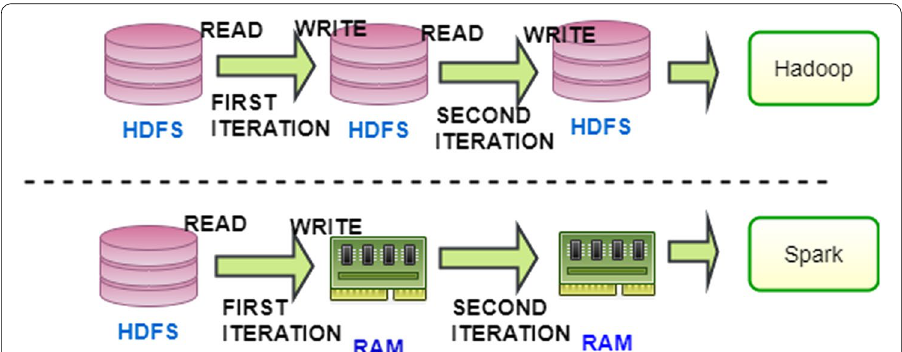
Fig. 2 Comparison between Hadoop and Spark in dealing with memory and disks: Hadoop is slower than Spark because it processes each task on two stages, map and reduce. Every two stages must output data to the disk. On the other hand, Spark operates in‑memory, therefore, it is